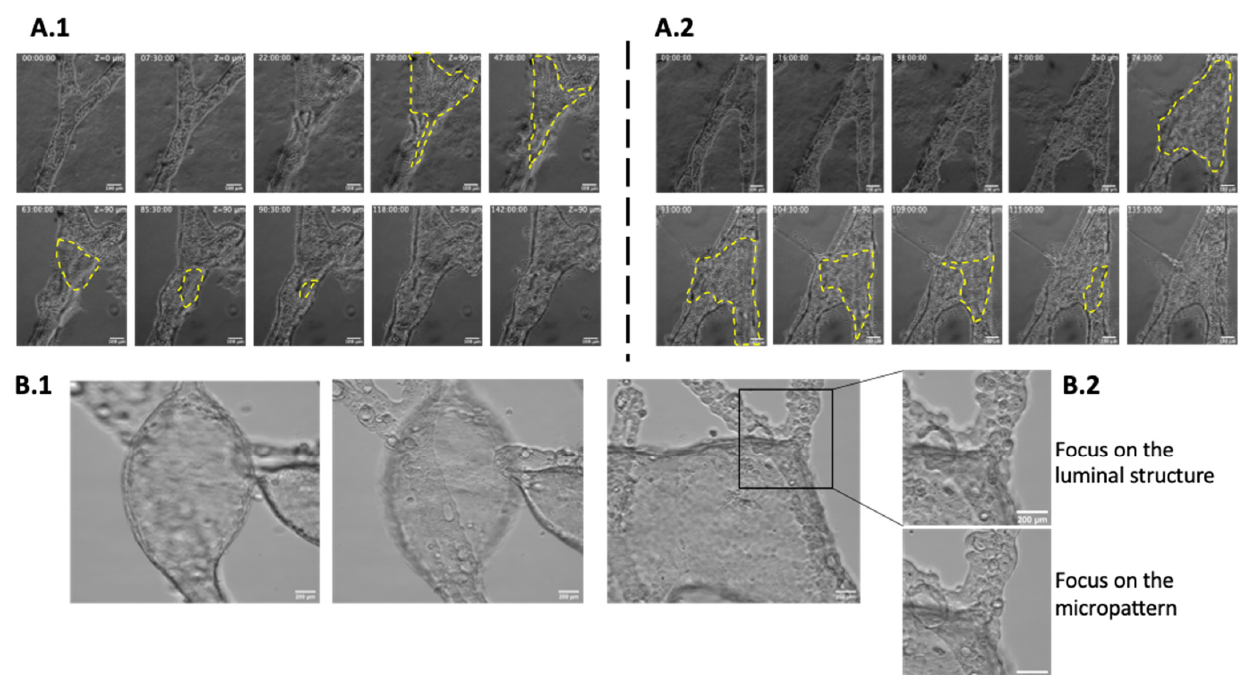
Figure 6. Self-organization process of biliary tubes. ( A ) time-lapse sequence of tubulogenesis along micropatterns: Self-organization of NRCs into a branched tube along a ( A.1 ) 45° and ( A.2 ) a 30° angle-branched micropattern. The yellow dotted region outlines the edges of the luminal cavity that progressively closes. Scale bars = 100 µm. ( B ) cellular connections along the biliary network: ( B.1 , B.2 ) cell connections formed along the biliary network between the luminal cavities and the underlying cell layer. Insets show a magnification of an anchoring point formed between the 3D luminal structure and the 2D cell layer. Scale bars = 200 µm.